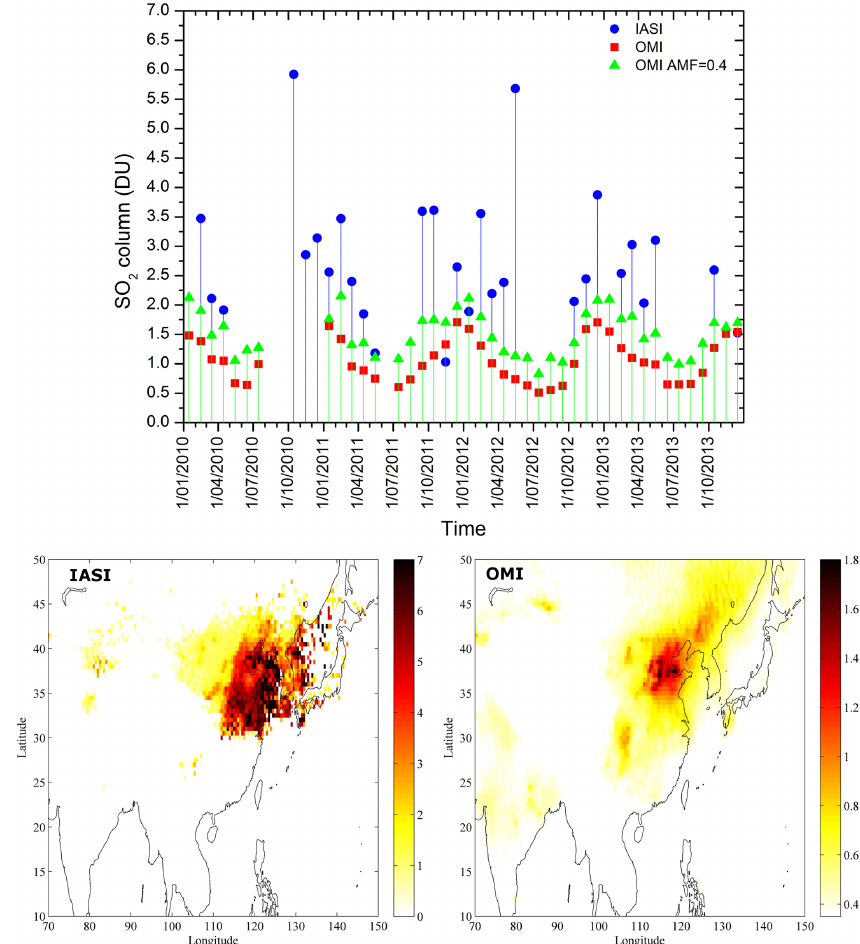
Figure 11. Top panel: monthly mean SO 2 columns (DU) retrieved for the period 2010–2013 above Beijing within a 125km radius from IASI (blue) and OMI (red) observations. Green triangles correspond to OMI measurements for which an AMF of 0.4 has been used to calculate vertical SO 2 columns. Details are given in the text. Bottom panels: spatial distributions of SO 2 (DU, different colour scales) above China for the period 2010–2013 from IASI observations (left panel) and from OMI observations (right panel, without AMF changes). SO 2 columns have been averaged on a 0.5 ◦ × 0.5 ◦